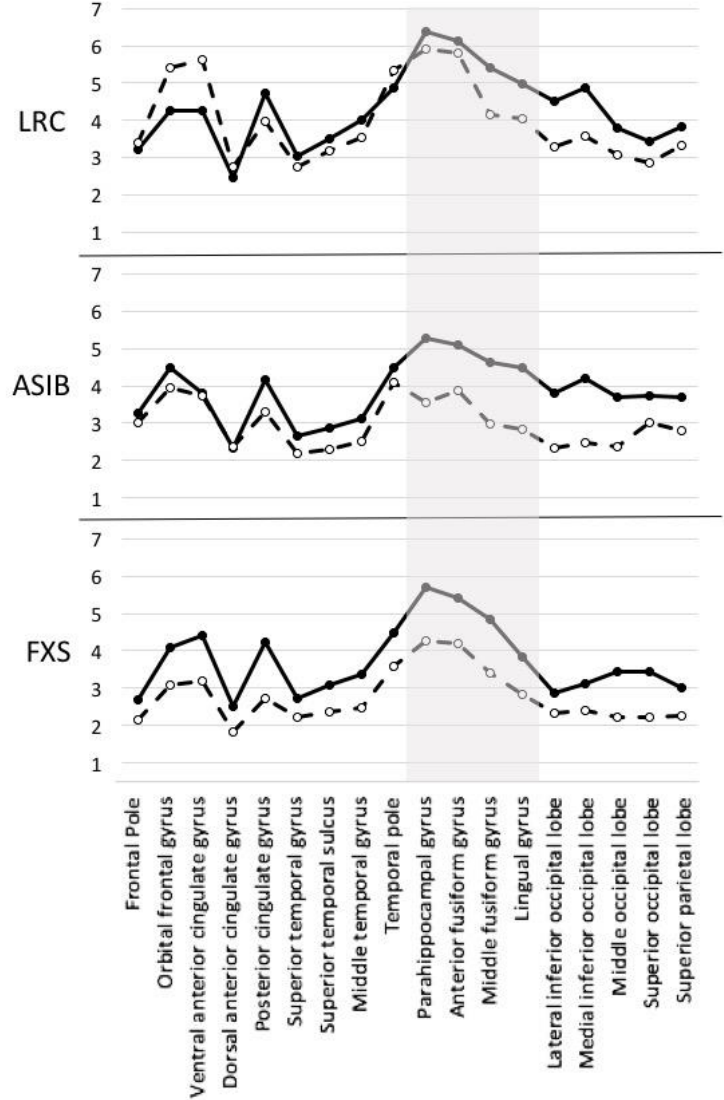
Figure 8. CDR activation to faces and toys is presented for each group and ROI; ROIs associated with the source of the N290 are highlighted in gray.